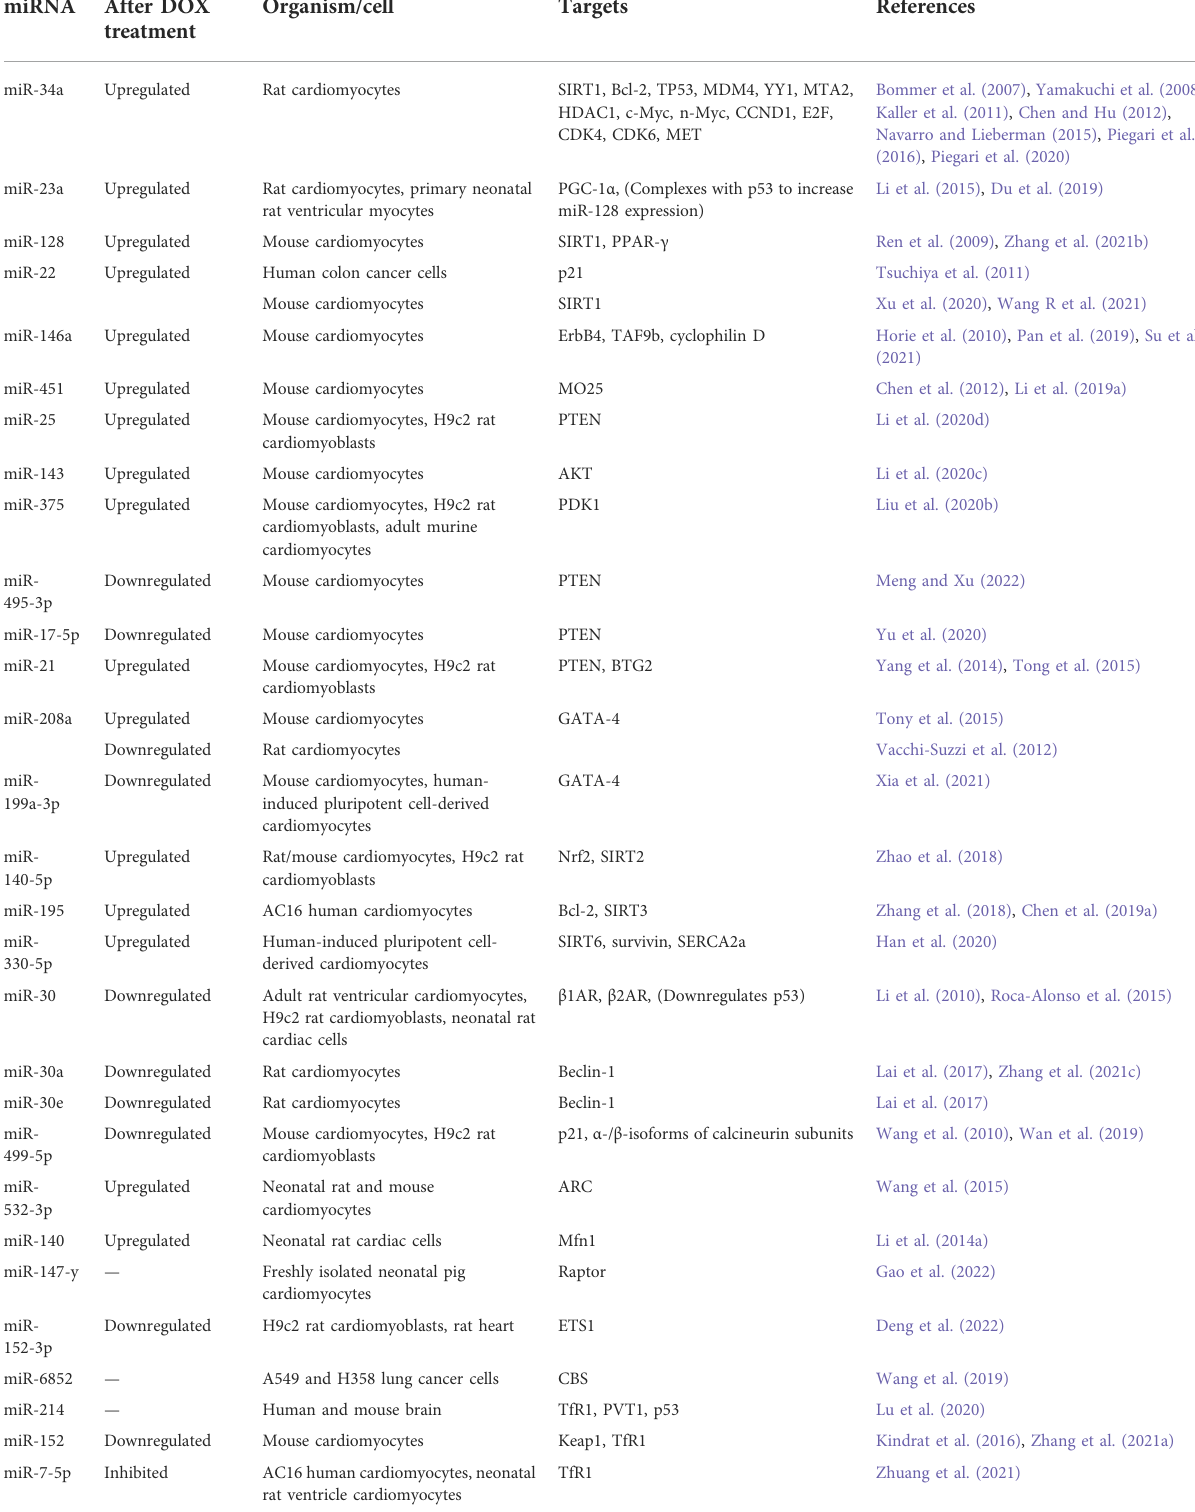
TABLE 1 List of miRNAs potentially involved in DIC.